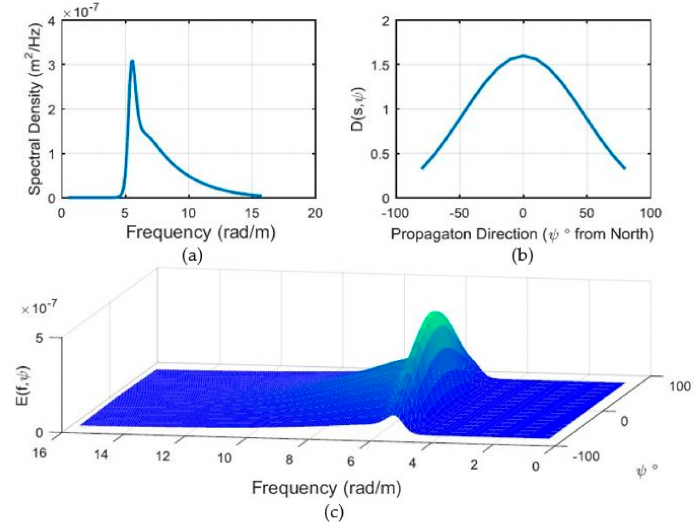
Figure 2. Wave spectrum, spreading function and directional spectrum for an Apel wave spectrum model with wind speed U = 5 m/s and fetch length of 5.5 m. ( a ) 1-D Apel wave spectrum; ( b ) Cos-2s spreading function; ( c ) Directional